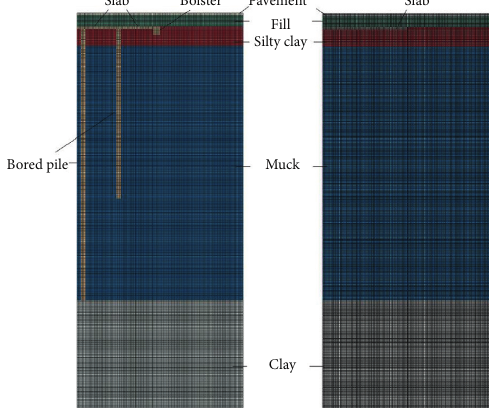
Figure 4: ABAQUS finite element simulation model.